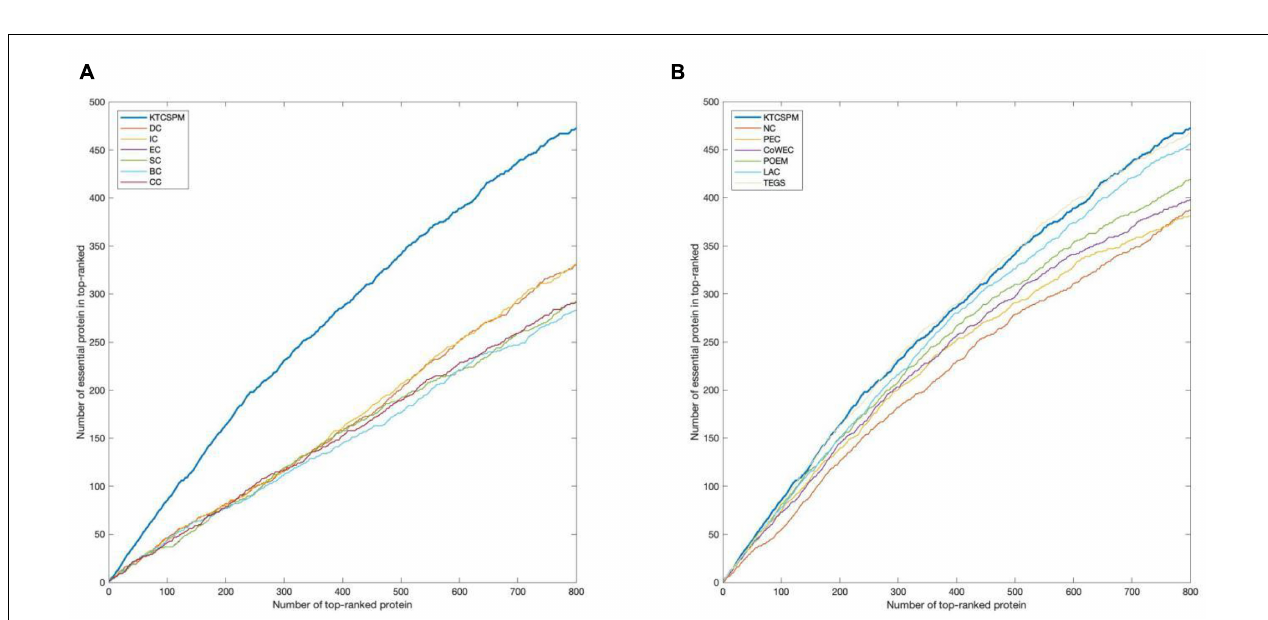
FIGURE 4 | The comparison results between key target convergence sets based prediction model (KTCSPM) and 12 competitive methods based on the DIP database under the jackknife methodology. (A) Comparison results between KTCSPM and DC, IC, EC, SC, BC, and CC. (B) Comparison results between KTCSPM and NC, PeC, CoWEC, POEM, LAC, and